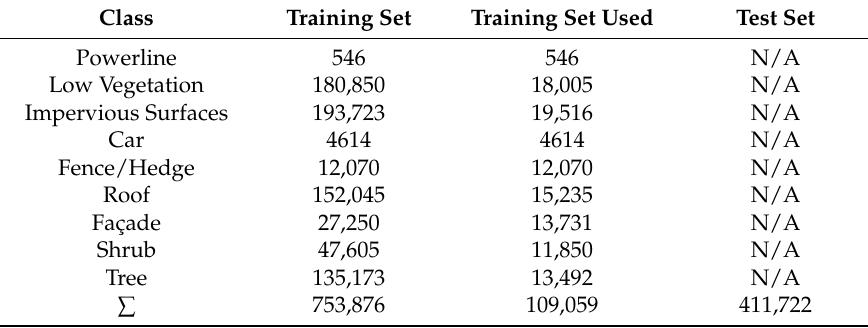
Table 1. Number of 3D points per